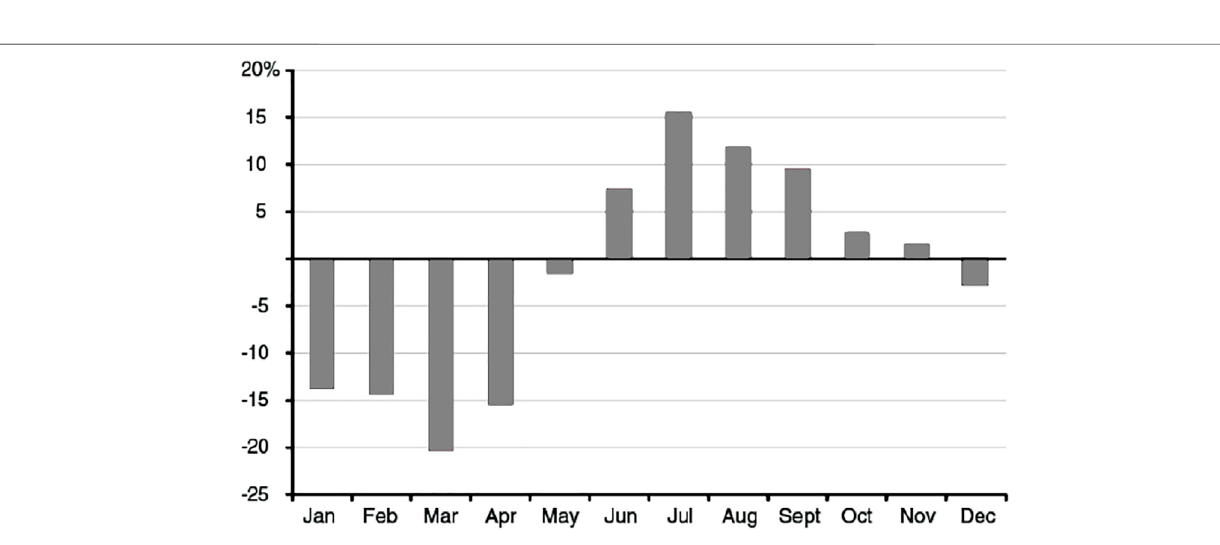
Frontiers in Environmental Science |